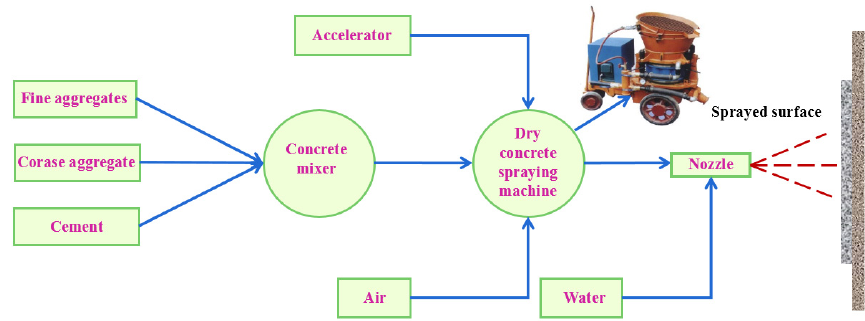
Figure 13. Process flow of concrete dry spraying.